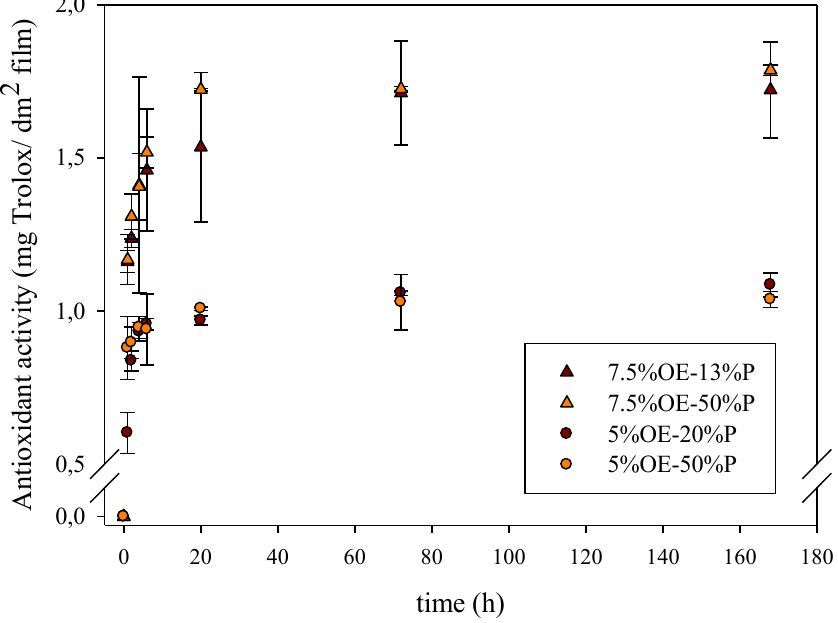
Figure 3. Kinetic of antioxidant activity of food simulants exposed to cellulose acetate-based films with different onion extract concentration (%OE w onion /w polymer ) and plasticizer